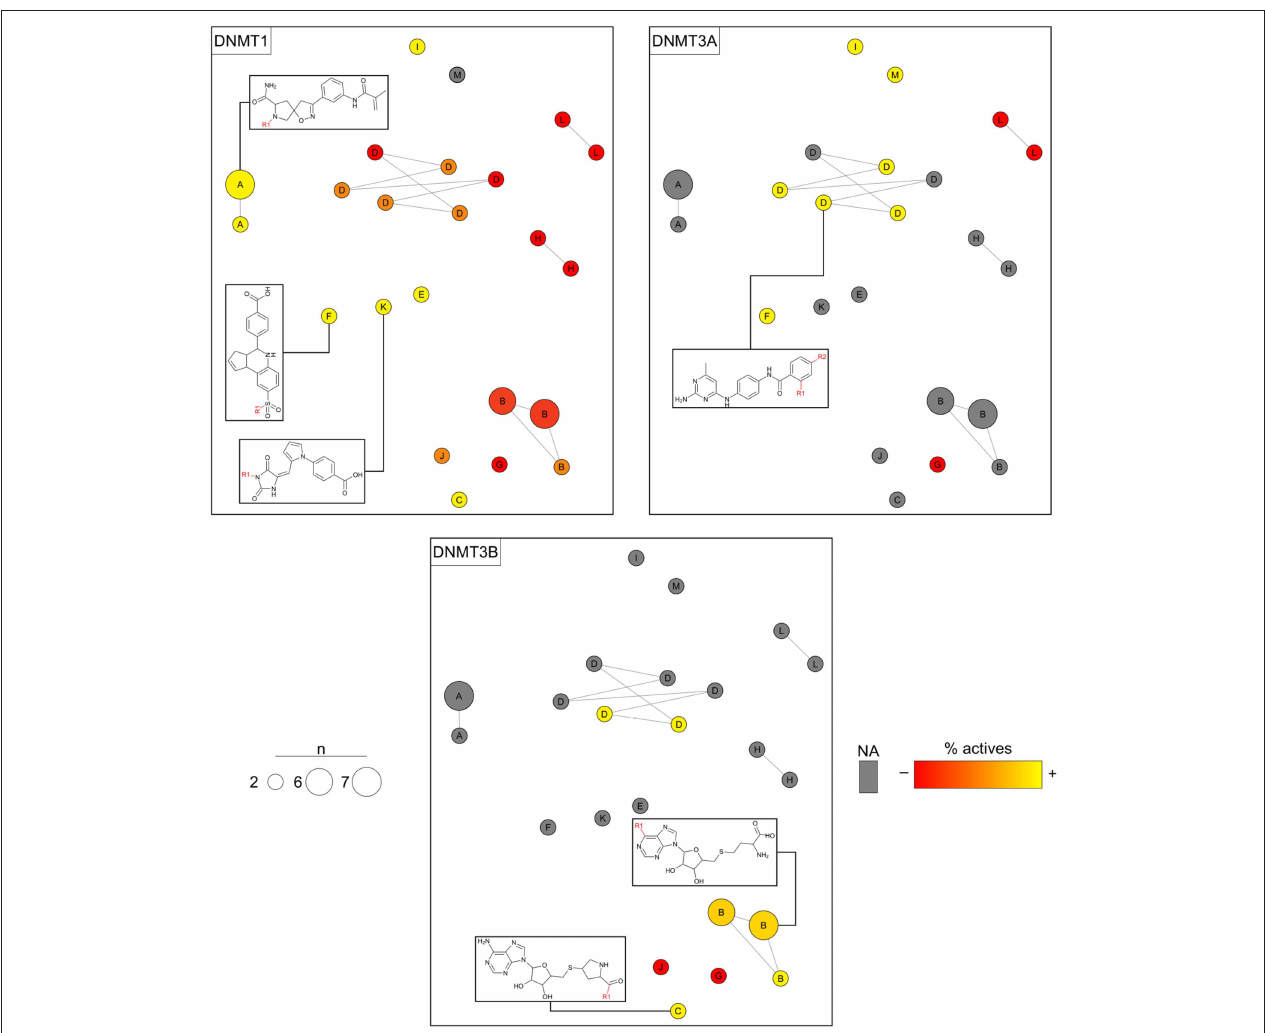
FIGURE 7 | Constellation plots for a dataset of DNA methyltransferase (DNMT) inhibitors tested with DNMT1, DNMT3A, and